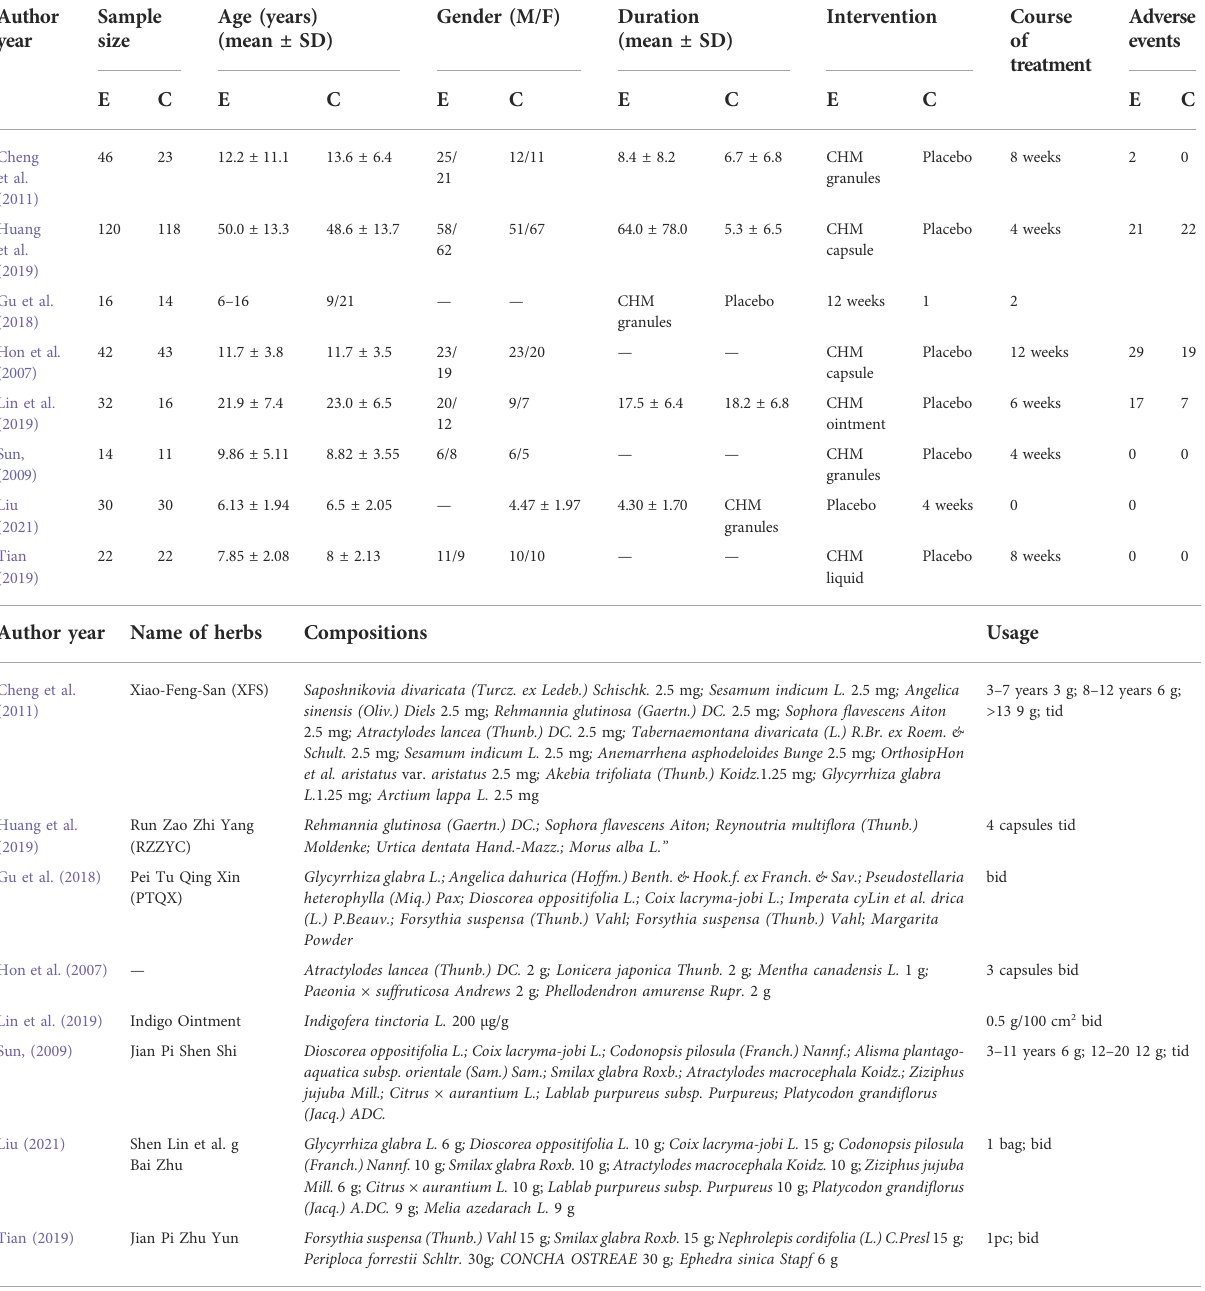
TABLE 1 Characteristics of the included